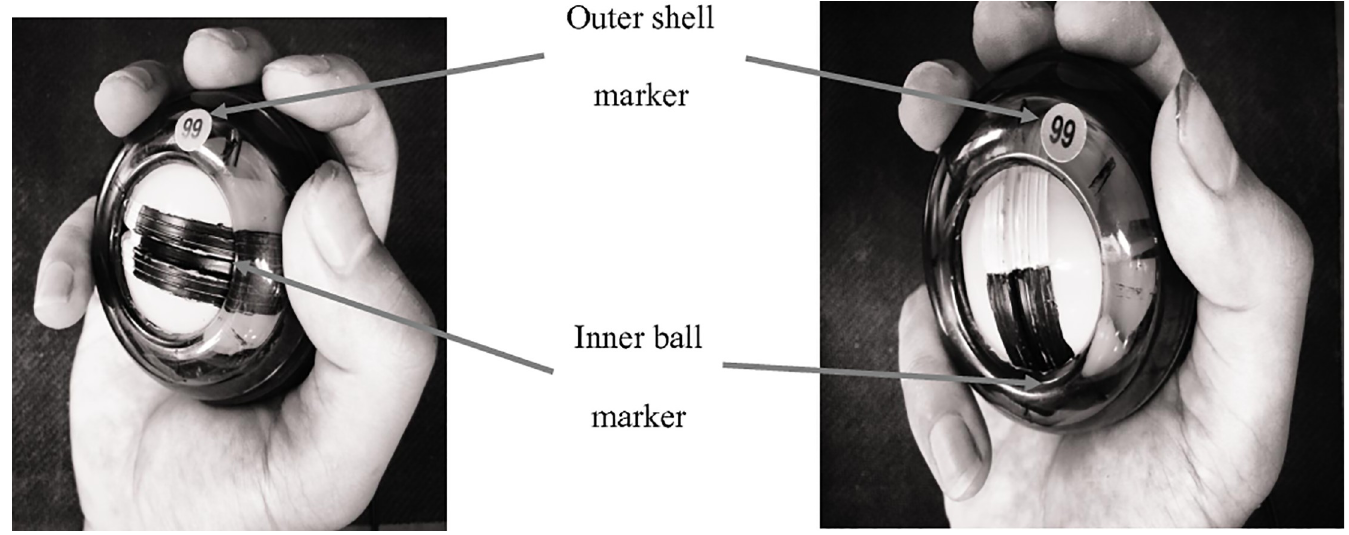
Fig 1. Illustrations of the marker locations of the outer shell and the inner ball of the roller